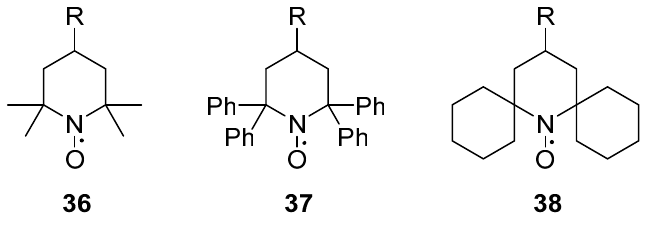
Figure 5. tructures of nitroxides with various steric groups on the 2, 6 positions.